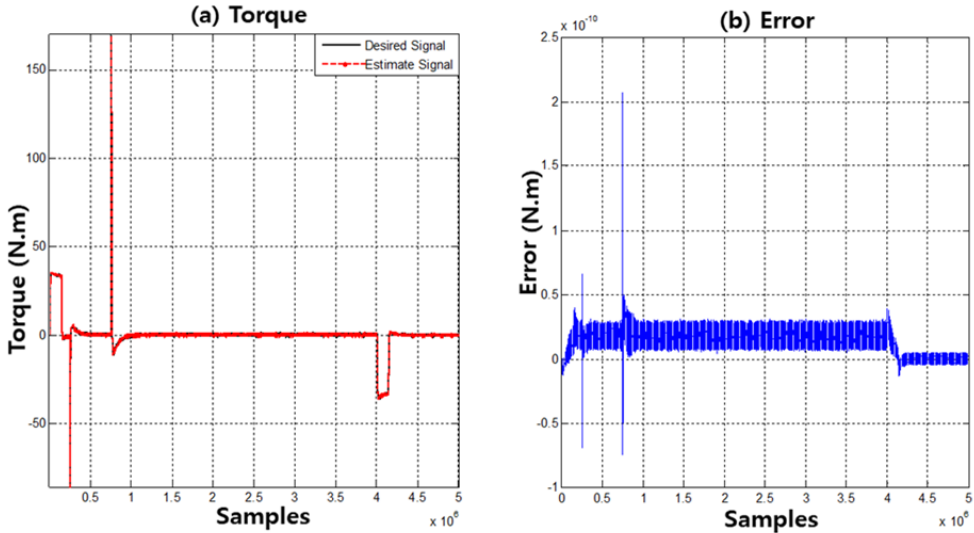
Figure 7. ARX-Laguerre orthonormal method for system identification/estimation in the normal condition: ( a ) desired and estimation torque and ( b ) error.